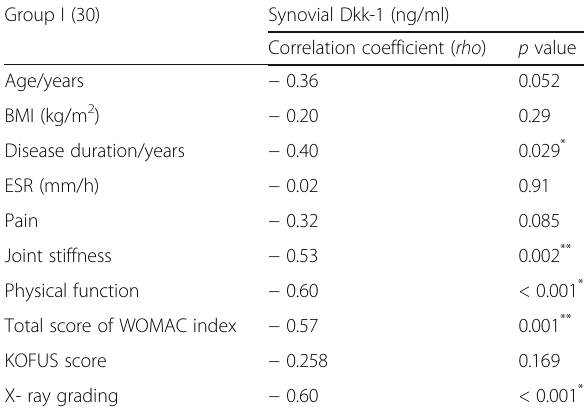
Table 4 Correlations of median synovial Dkk-1 (ng/ml) level with mean demographic, clinical and laboratory parameters in